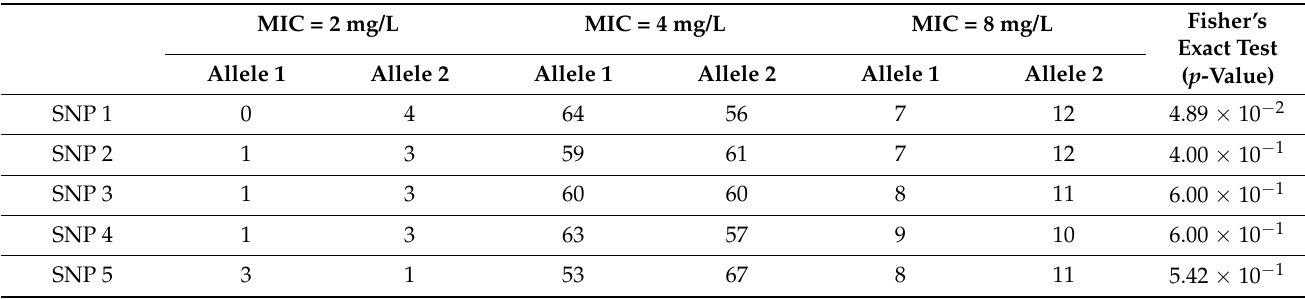
Table 6. Allele distribution at five SNP sites among the 143 progeny strains. The variant alleles are separated based on AMB MIC groups (MIC = 2 mg/L, 4 mg/L or 8 mg/L). Fisher’s exact tests (3 × 2 contingency table) were conducted between MIC groups and the inherited parental allele, with p -values listed. Differences were considered statistically significant at p <